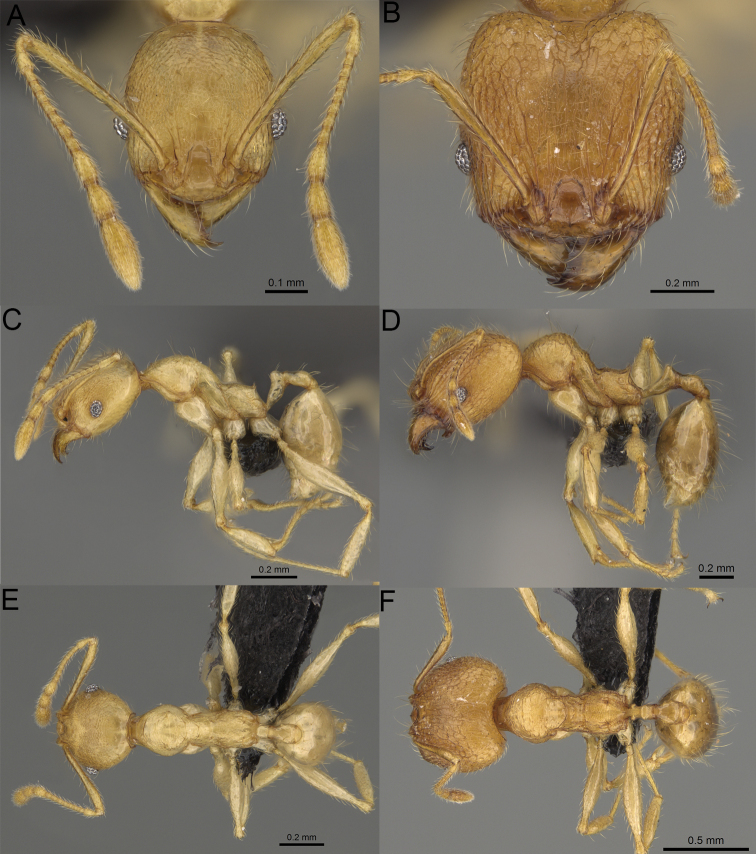
Pheidole
vony Forel, full-face view (A), profile (C), and dorsal view (E) of minor paratype worker (CASENT0498053) and full-face view (B), profile (D), and dorsal view (F) of holotype major worker (CASENT0498055).